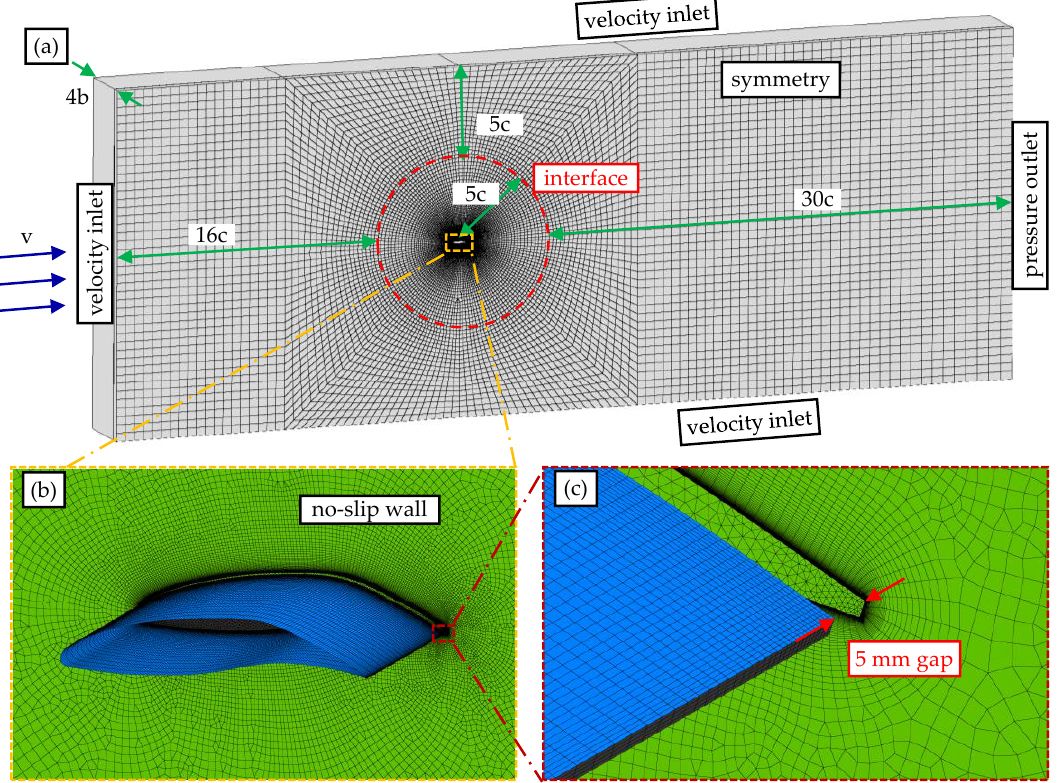
Figure 14. Computational mesh for the deformed wing. ( a ) Full view. ( b ) Zoom-in mesh detail around the airfoil. ( c ) Zoom-in mesh detail near the trailing edge.